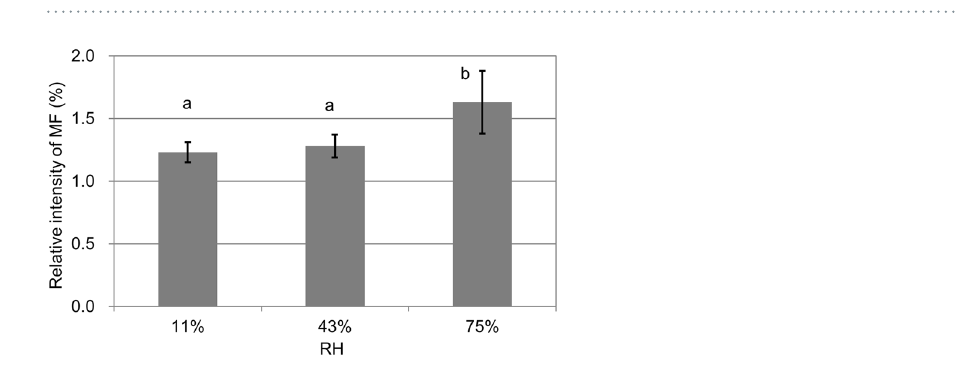
Figure 5. Representative total ion images and MF distribution maps of the cured samples conditioned under RH of 11% ( a and b ), 43% ( c and d ), and 75% ( e and f ). The typical ROIs of the cell walls are enclosed with blue lines. Arrows indicate MF deposited on the inner surface of the cell walls. Scale bar: 100 μ m.